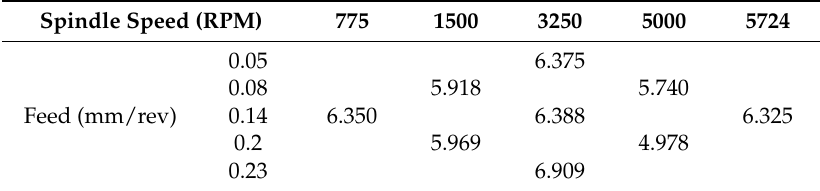
Table 2. The effect of the drilling conditions on the average roundness, in µ m.